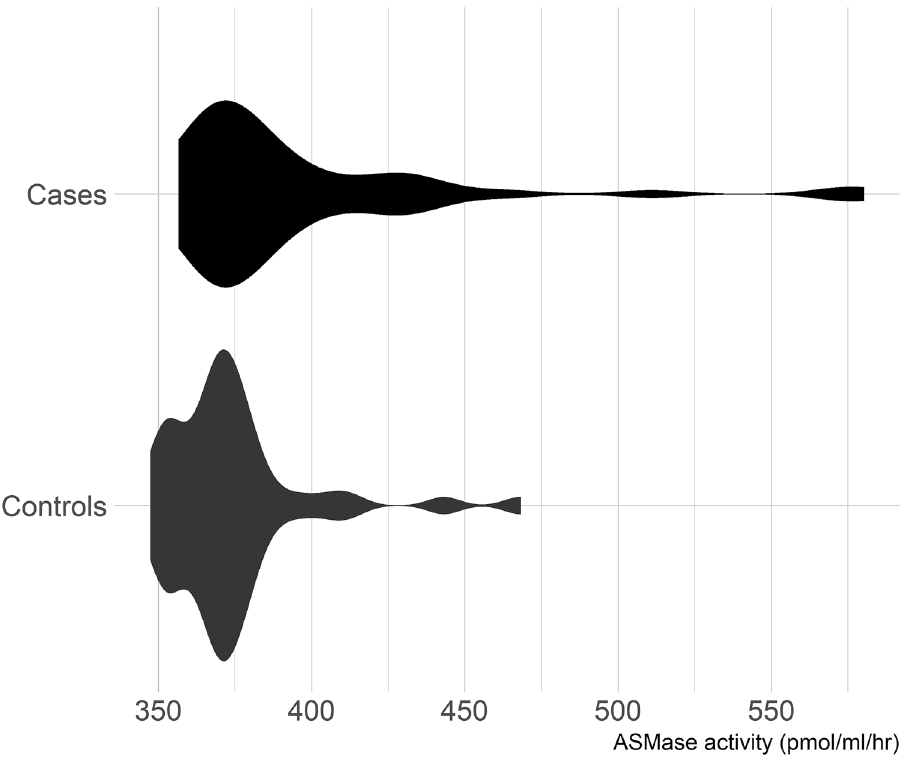
Figure 1. Distribution of the activity of serum acute sphingomyelinase in obese pediatric patients and healthy controls.